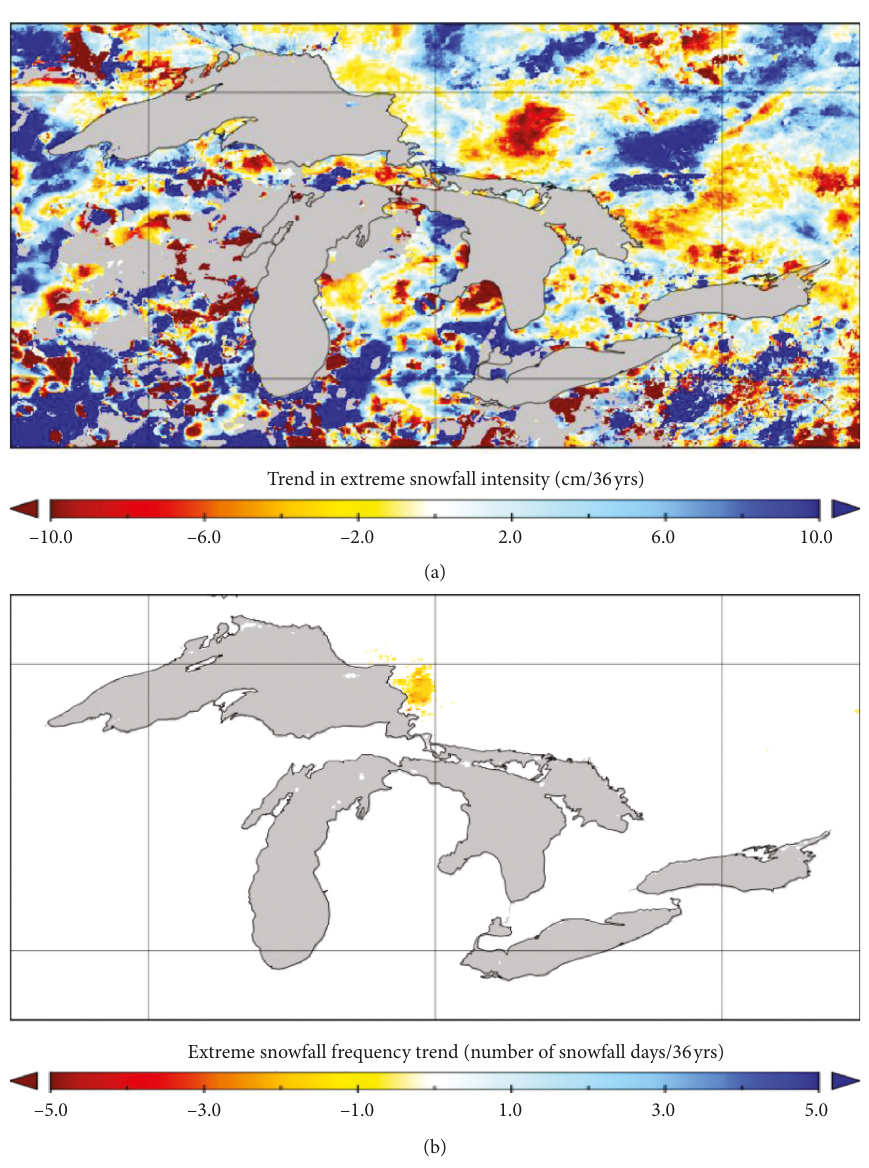
Figure 8:1980 to 2015 trends in extreme snowfall (a) intensity and (b) frequency, for the month of February. Gray pixels represent grid cells with no trend computed because the region contains some years with no extreme snowfall